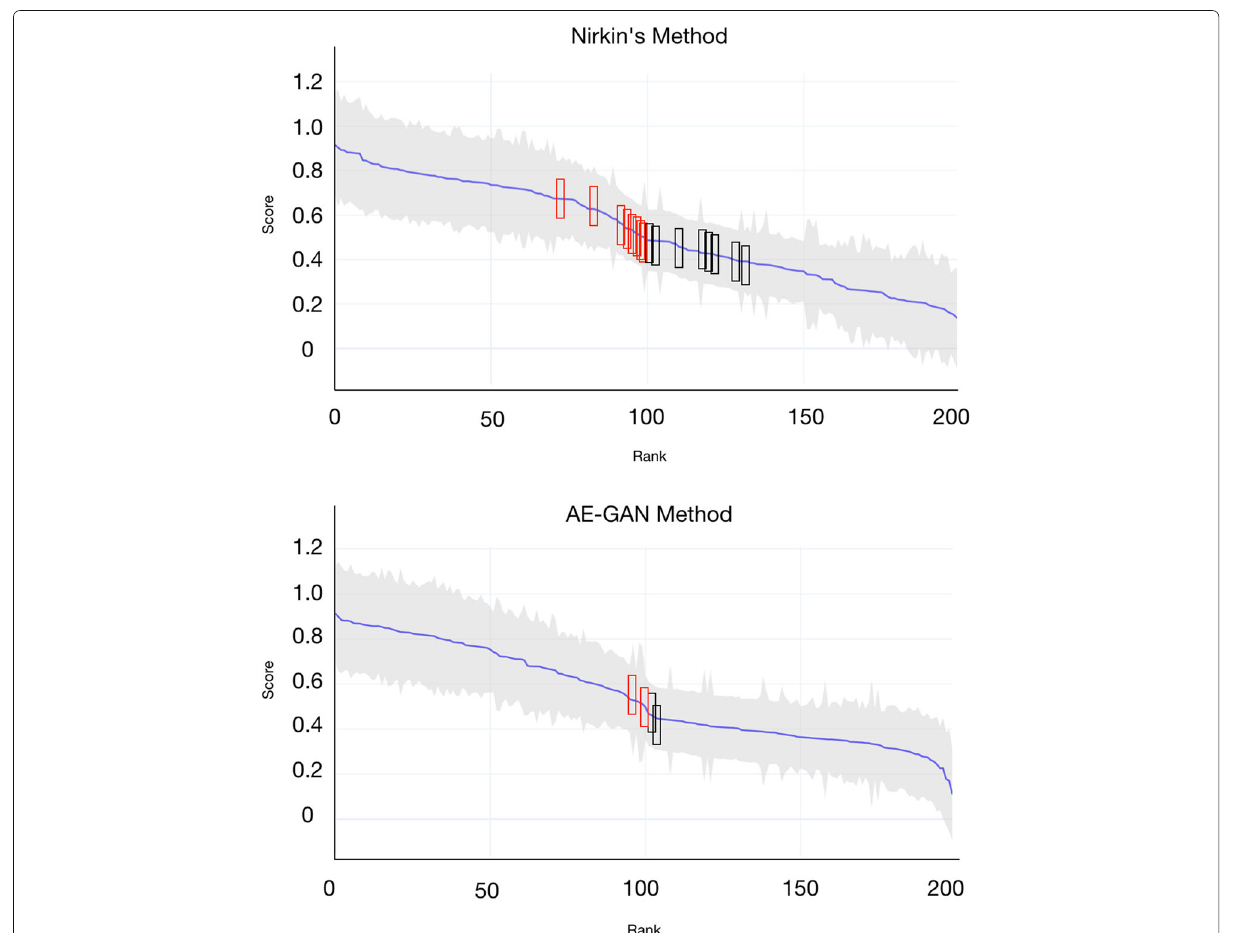
Fig. 5 Human subjects rank of the manually selected 200 images. Left to right, from most real to most fake